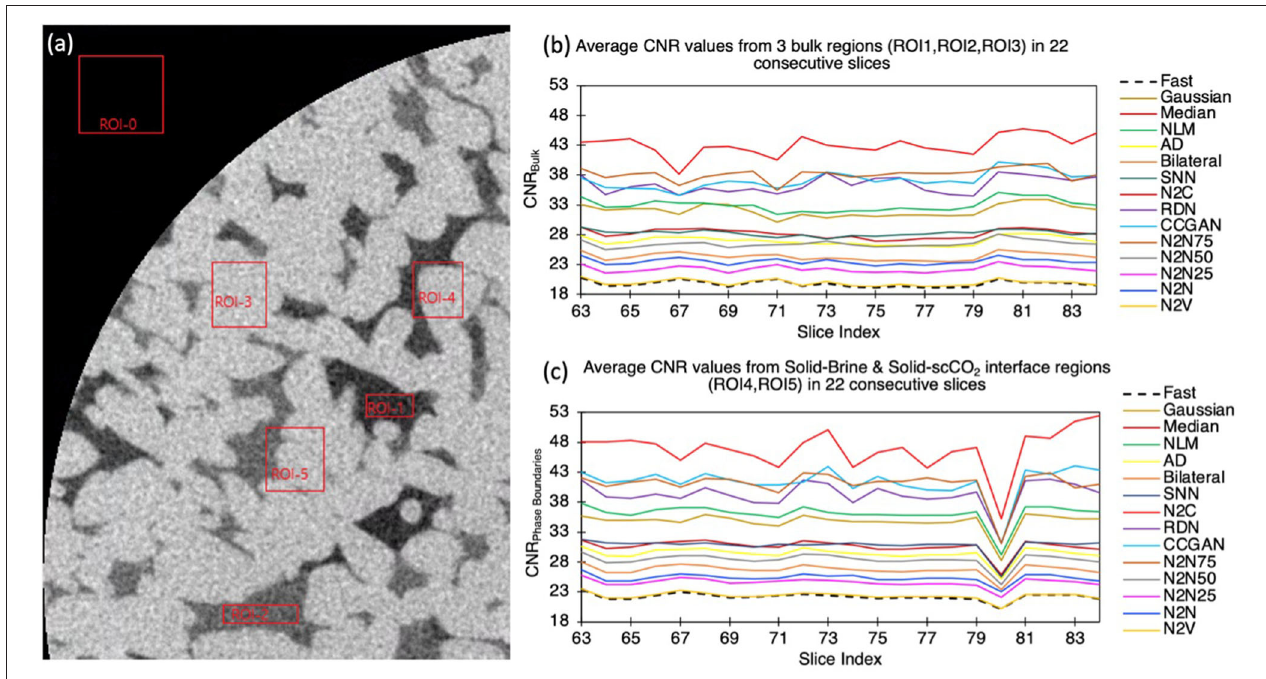
FIGURE 5 | Comparison of contrast-to-noise (CNR) ratio for denoised datasets against noisy LQ dataset. (a) Example regions of interest (ROI 1–5) considered for bulk and edge CNR calculations are shown in red boxes. ROI 0 represents the background ROI against which contrast is calculated. (b) Average CNR of bulk phases (solid, brine, scCO 2 ) in 22 slices, and (c) Average CNR of phase boundaries (solid-brine and solid-scCO 2 ) in 22 slices.